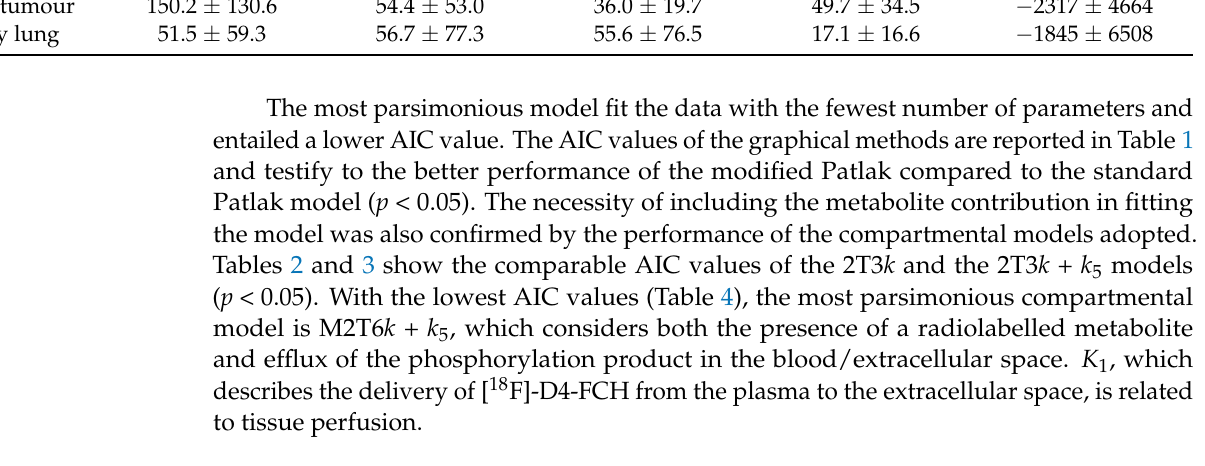
Table 3. The results of the compartmental analysis.